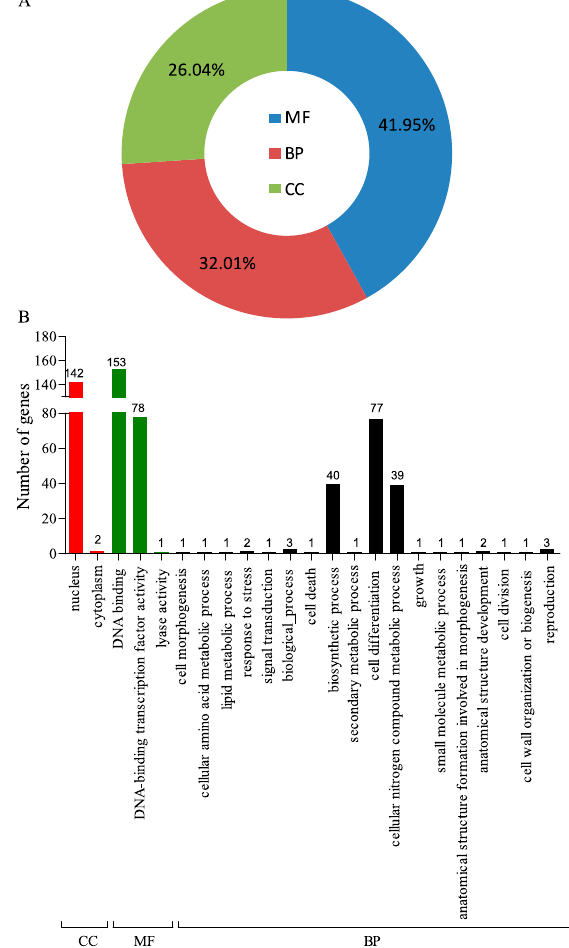
Figure 4. Gene Ontology (GO) analysis of R2R3-MYB genes in pecan. CC: cellular component (red); MF: molecular function (green); BP: biological process (black). ( A ) Each slice in the pie chart represents the relative abundance of GO categories of 153 pecan R2R3-MYBs and their detailed classifications ( B ).